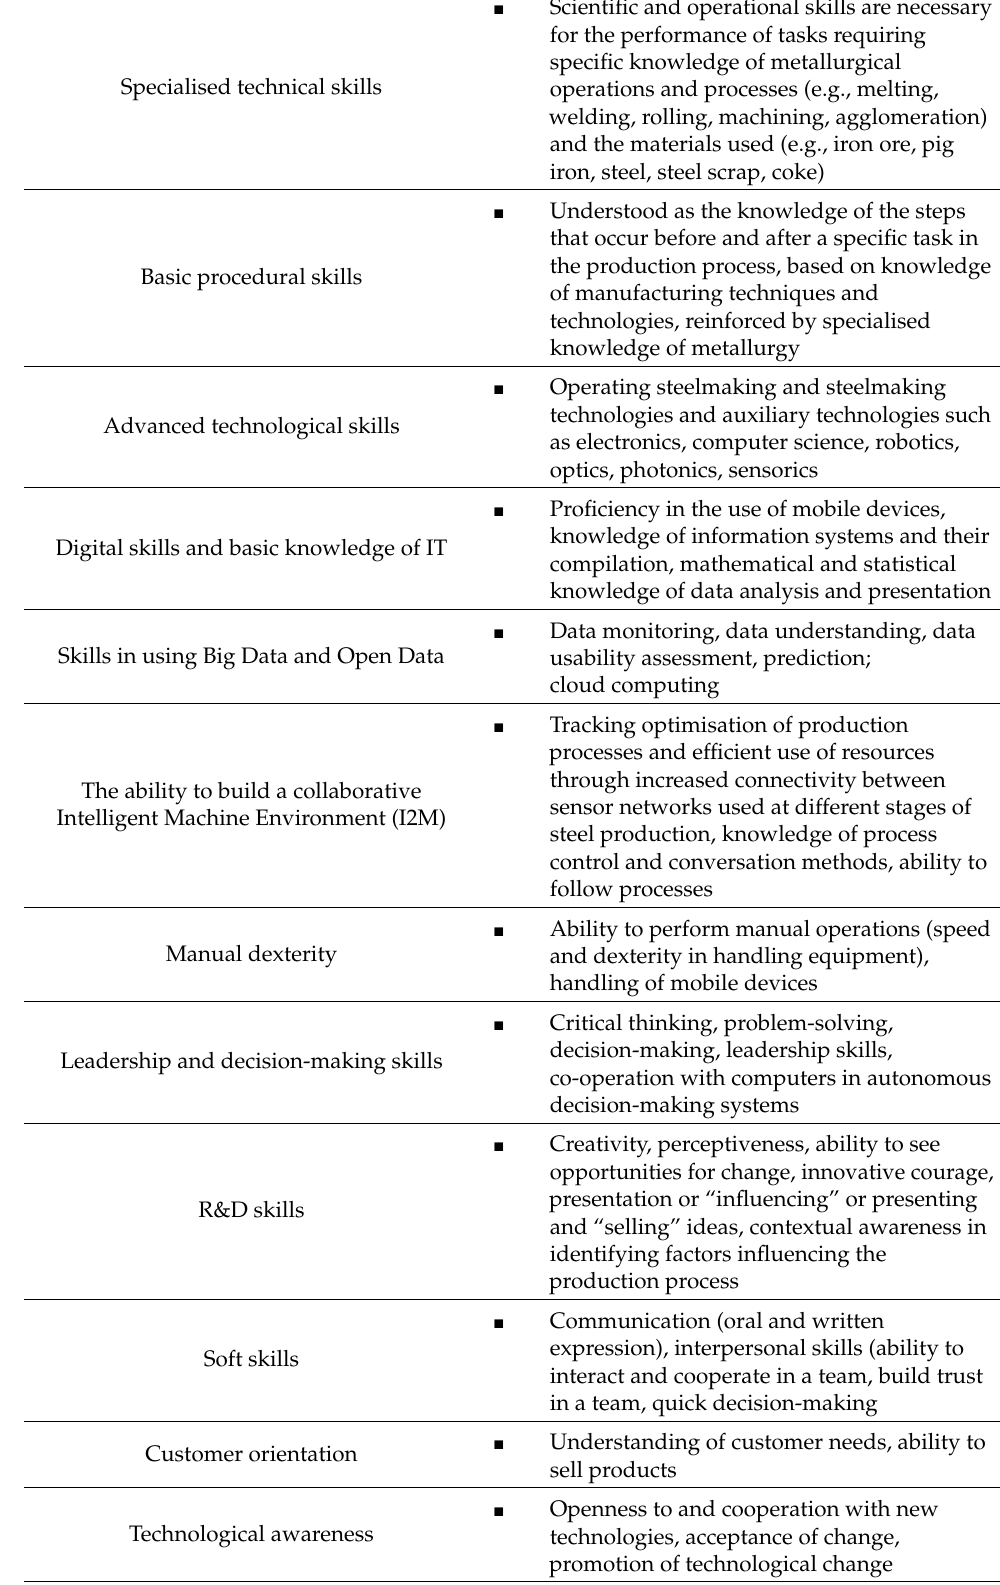
Table 3. Key skills and competencies of employees in the steel industry towards I4.0.